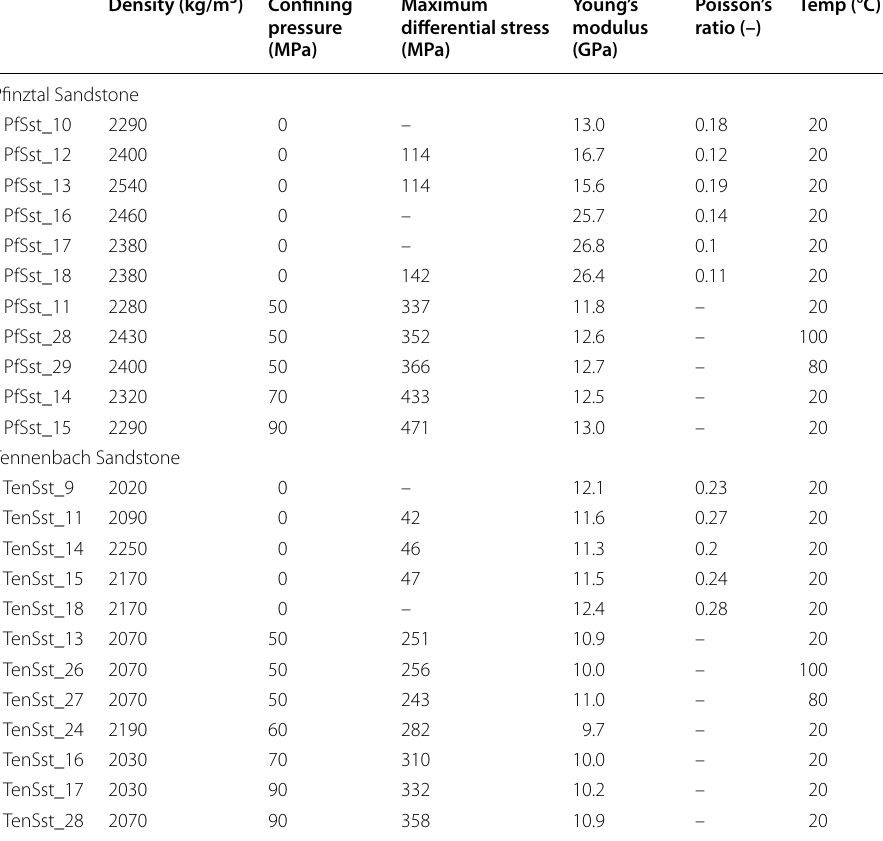
Table 2 Experimental data for PfSst and TenSst from uniaxial and triaxial